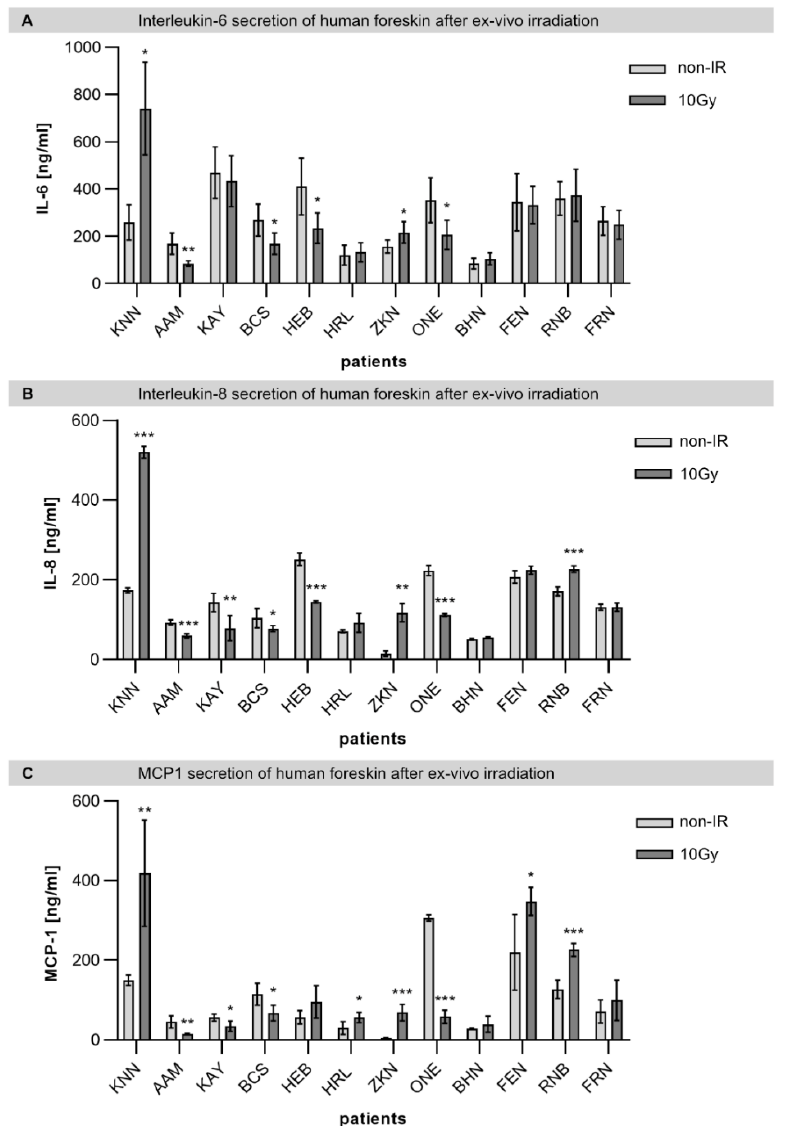
Figure 3. Patient-to-patient variability of cytokine expression in foreskin explants before and after ex vivo IR exposure. Graphic presentation of the quantification of IL-6 ( A ), IL-8 ( B ), and MCP-1 ( C ) measured by ELISA in the supernatant of foreskin explants before (non-IR) and after IR exposure (10 Gy; 24 h post-IR) for individual donors ( n = 12). * p < 0.1; ** p < 0.01; *** p <